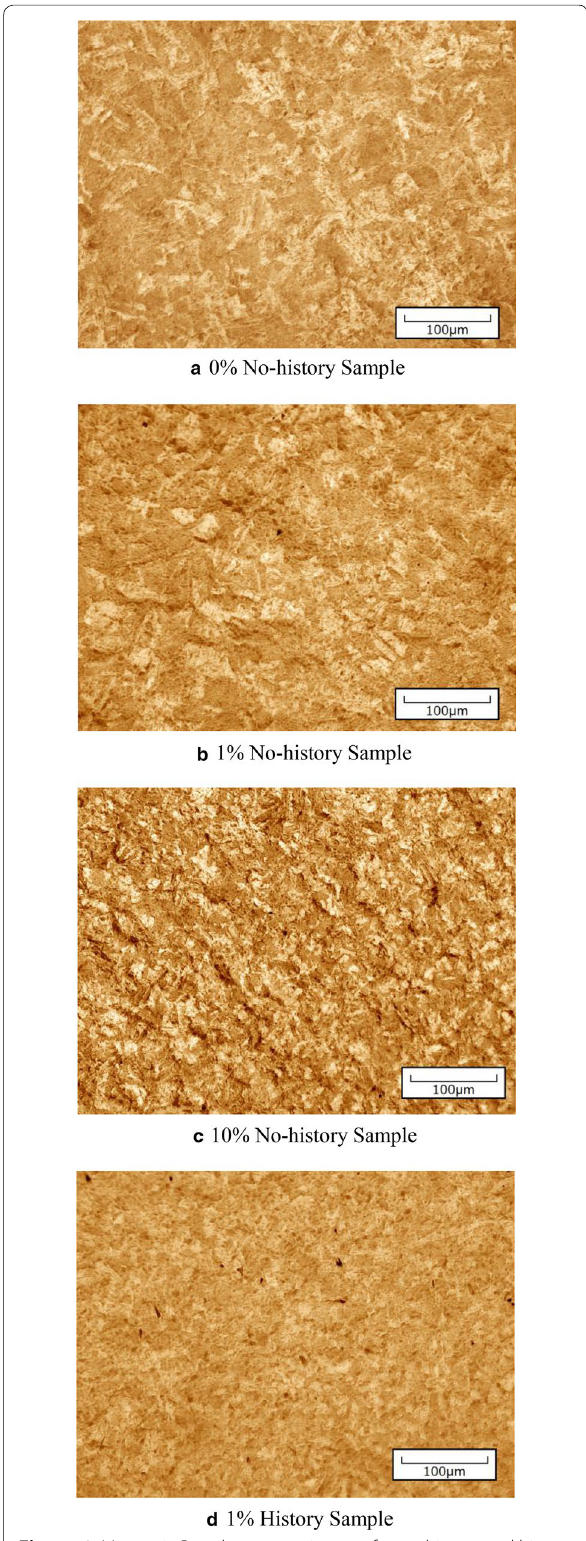
Figure 6 Magnetic Powder-pattern images for no-history and history sample of different plastic deformation (200